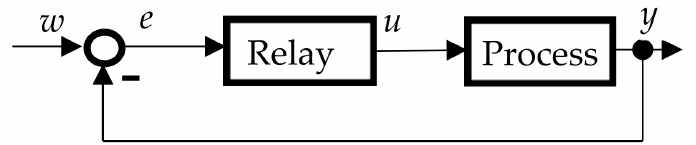
Figure 1. A process under relay control.